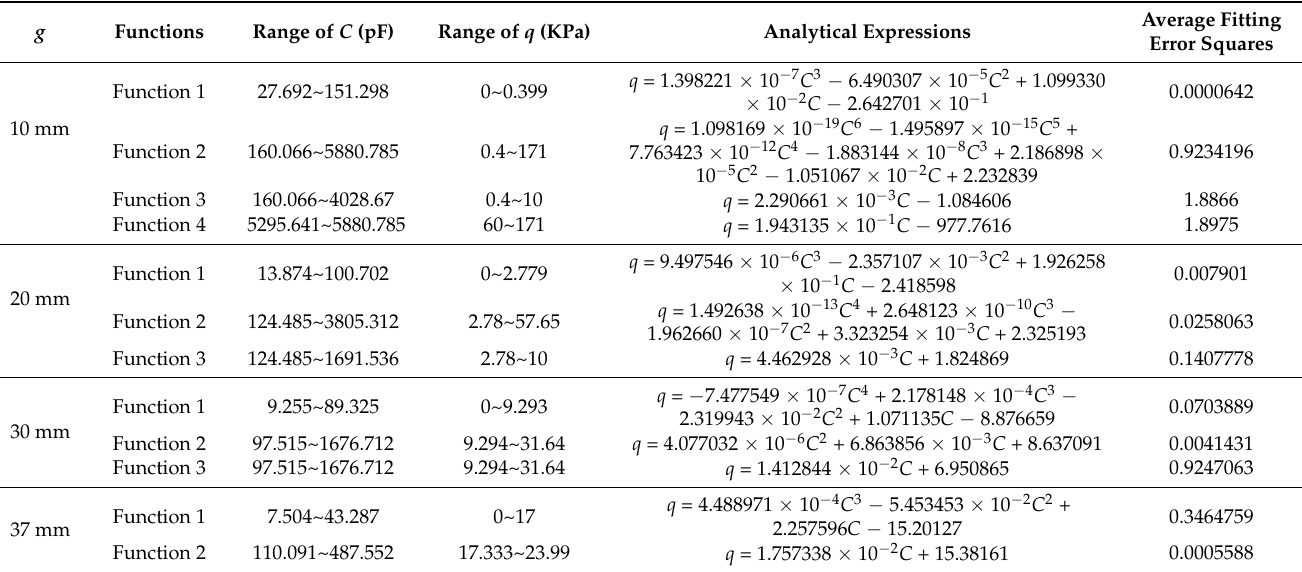
Table 1. The analytical expressions of the fitting Functions in Figures 3–6 and the ranges of the input capacitance C and output pressure q , where a = 100 mm, h = 1 mm, t = 0.1 mm, E = 7.84 MPa, ν = 0.47, and g = 10 mm, 20 mm, 30, mm and 37 mm.